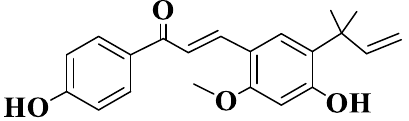
Figure 1. Structure of Licochalcone A.